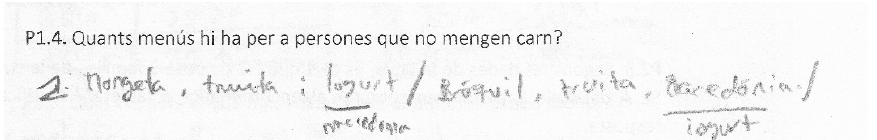
Figure 10. Incorrect answer of Q4. Enumeration strategy. PC1 error (translation: 2: Green beans, omelet and yogurt-fruit salad/Broccoli, omelet, fruit salad-yogurt./ ).